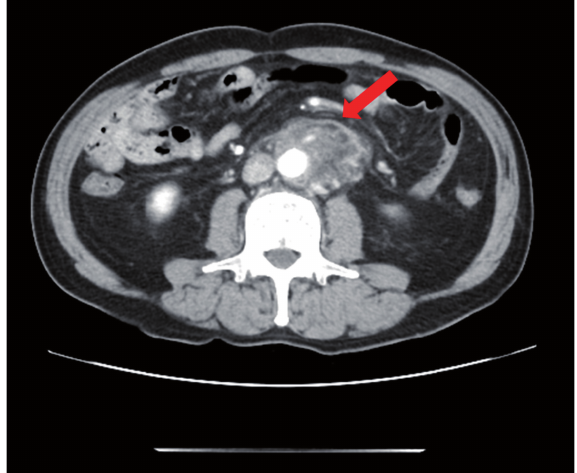
figure 2 - A) Enhanced computed tomography revealed an exponential increase of the low density area.